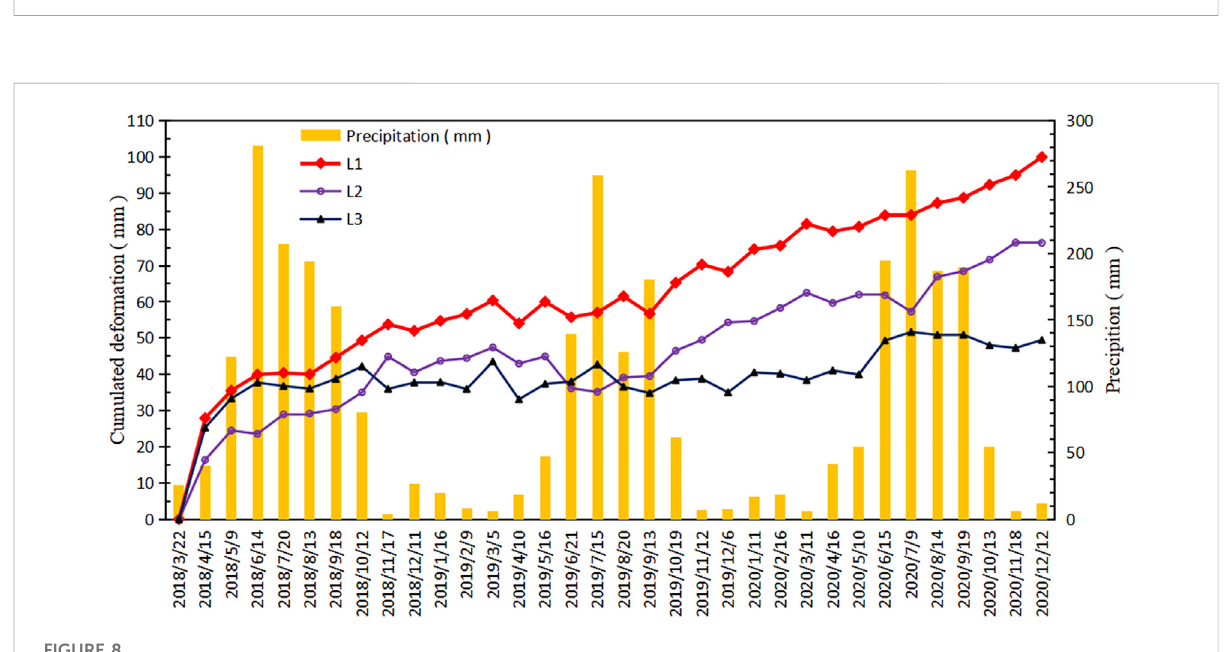
FIGURE 7 Remotesensingimageandtime-seriesdeformationmonitoringresultsoftheleftmountain. (A) Opticalremotesensingimage; (B) Deformation velocity; (C) Field investigation picture.